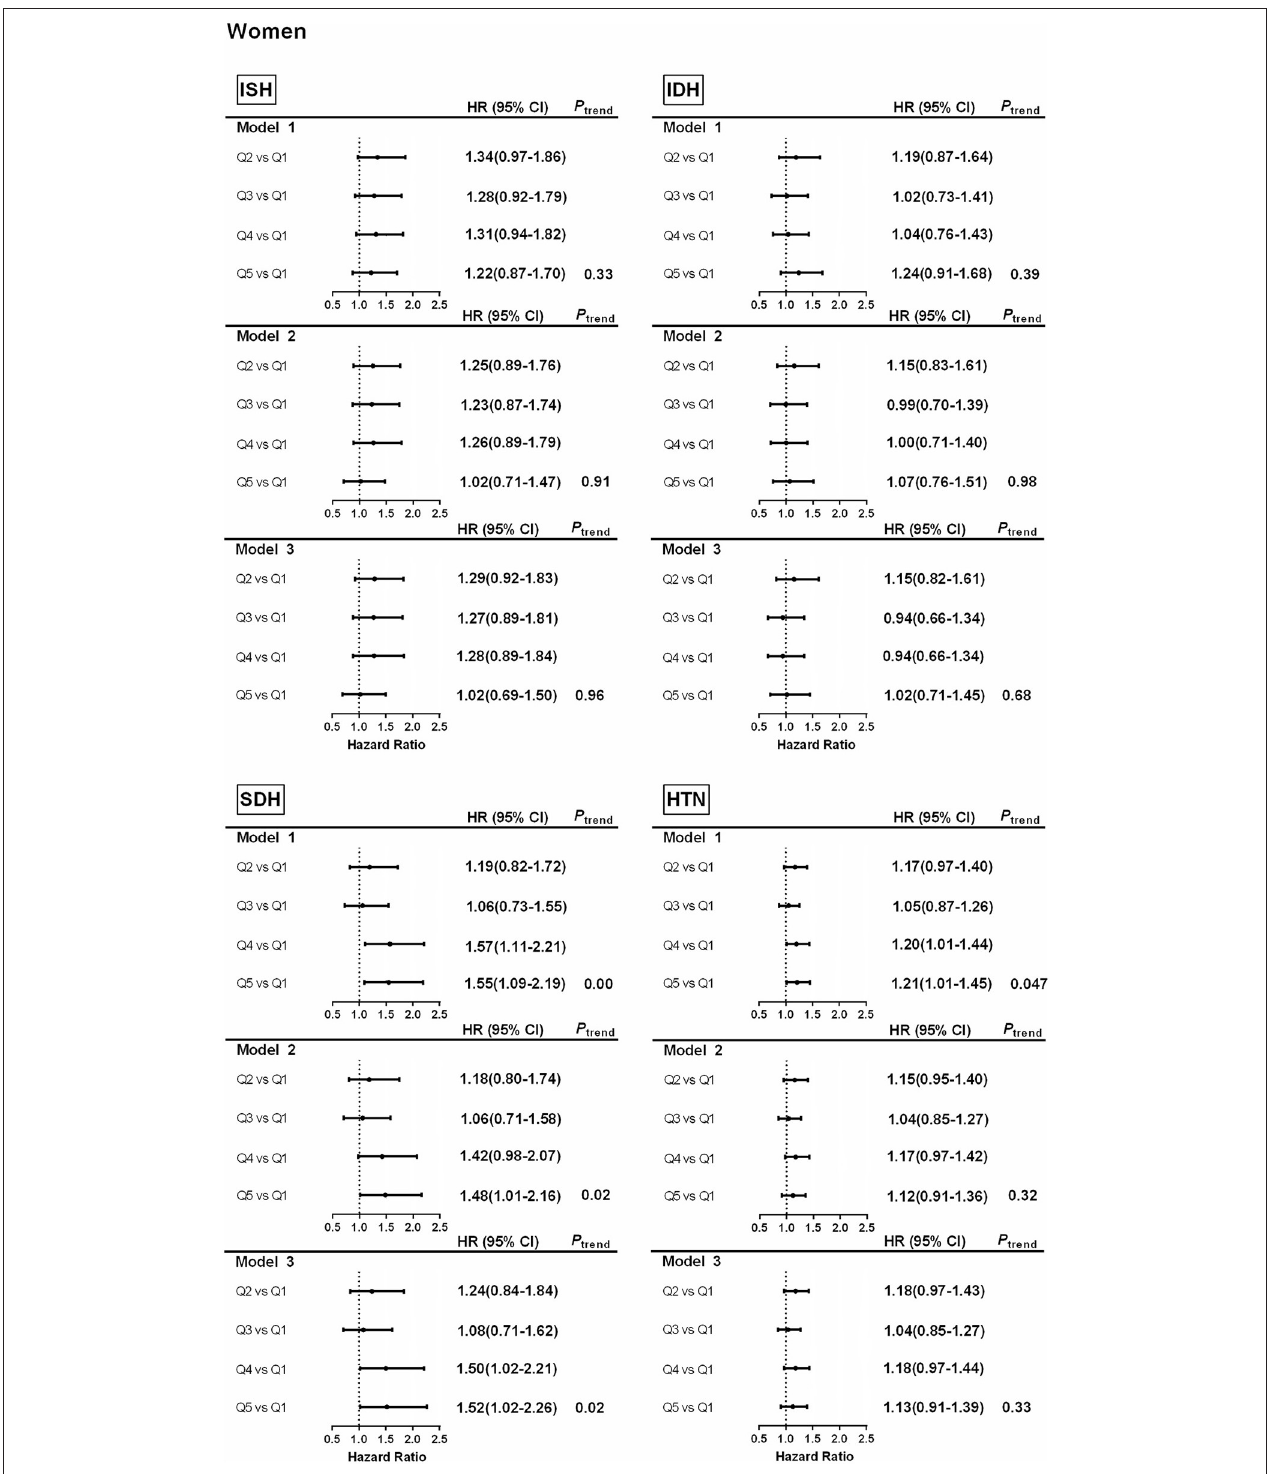
FIGURE 4 | Associations between percentage energy from carbohydrate by quantiles and hypertension and subtypes in women. Model 1. Hazard ratios and 95% CIs are adjusted for age. Model 2. Hazard ratios and 95% CIs are adjusted for age, urban or rural location, education level, waist circumference, ever smoking (never, ever), alcohol drinking (abstainer or drinker), personal income, BMI (underweight, normal weight, overweight, and obesity). Model 3. Hazard ratios and 95% CIs are adjusted for age, urban or rural location, education level, waist circumference, ever smoking (never, ever), alcohol drinking (abstainer or drinker), personal income, BMI (underweight, normal weight, overweight, and obesity), physical activity and energy intake. ISH, isolated systolic hypertension; IDH, isolated diastolic hypertension; SDH, systolic–diastolic hypertension; HTN, hypertension.